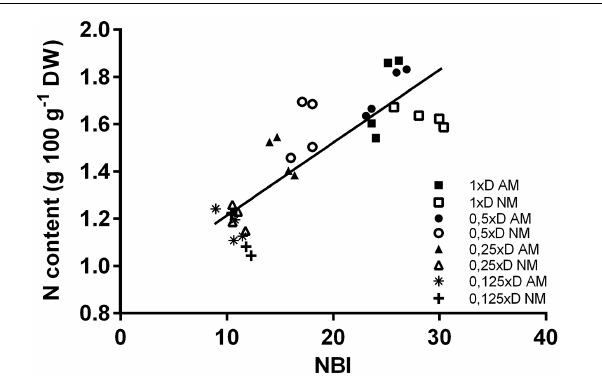
FIGURE 3 | Correlation between the Nitrogen Balance Index (NBI) and the nitrogen content of the middle leaves. NM, non-mycorrhized plants; AM, mycorrhized plants. Data was collected for analysis ( n = 32) from four fertilization variants (1xD, 0.5xD, 0.25xD, 0.125xD). Both nitrogen content (expressed as weight units per leaf dry mass) and NBI measurements were done on the same plants and leaves (L4 + 5, ear leaf and leaf above the